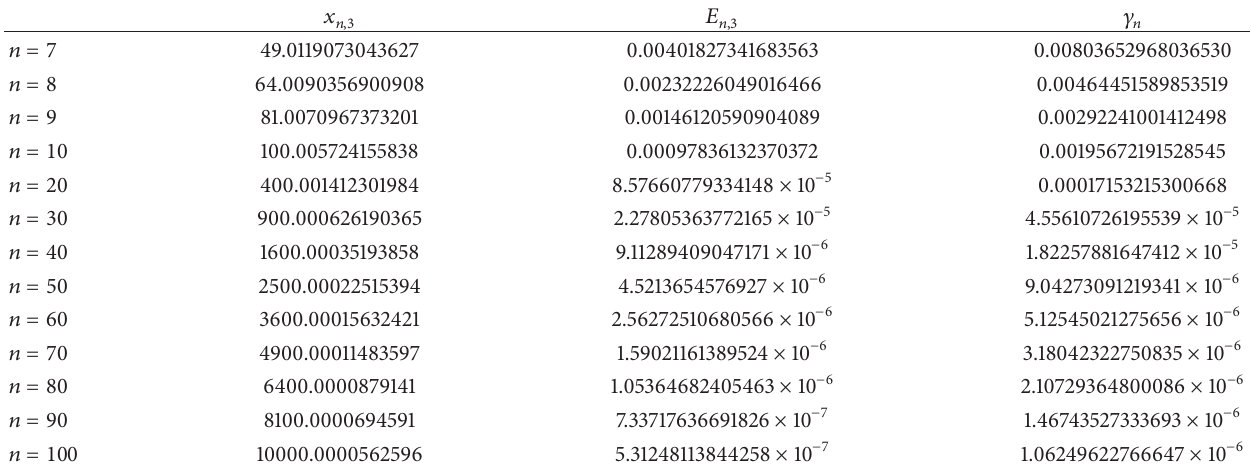
Table 1: Estimations for 𝑇(𝑝 1 ) .